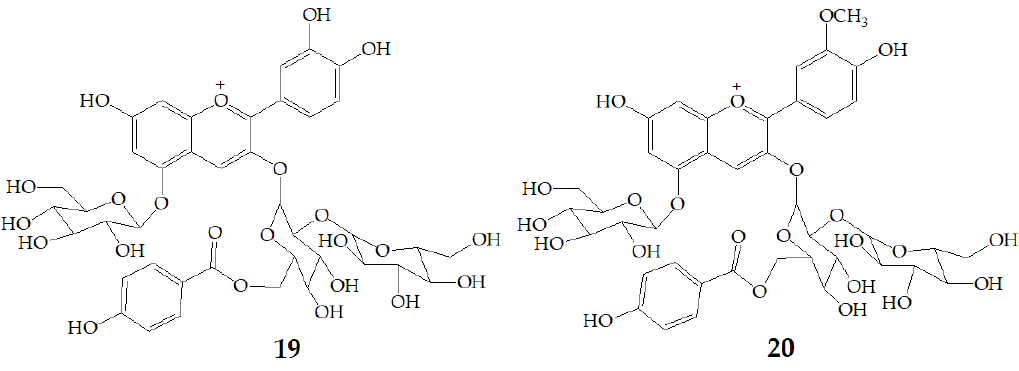
Figure 4. Chemical structures of compound 19 , 20 .